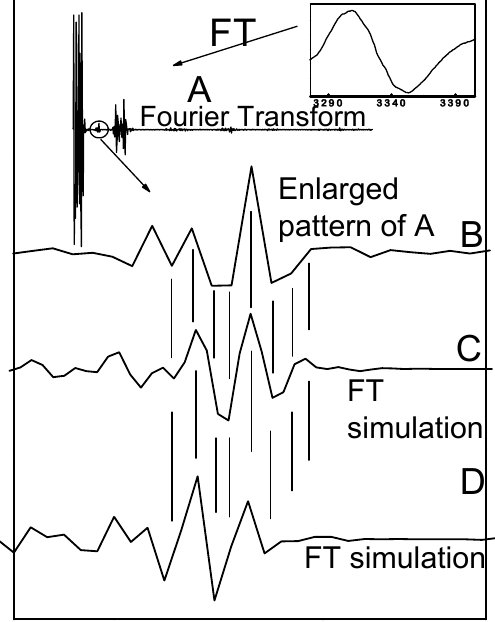
Figure 6. Fourier transform of the X-band CW-EPR spectrum of the complex [Cu( L -His) ([Cu] = 2 mM) in the phosphate buffer at pH = 7.3. ( A ) Fourier transform of the X-band CW EPR spectrum measured at room temperature. Insets: High-field band of the EPR spectrum measured at room temperature. ( A ) Real part of the FT-EPR spectrum; ( B ) Enlargement of the circled region; ( C ) Part of the simulated FT-EPR spectrum assuming four nitrogens; ( D ) Part of the simulated FT-EPR spectrum assuming three nitrogens.